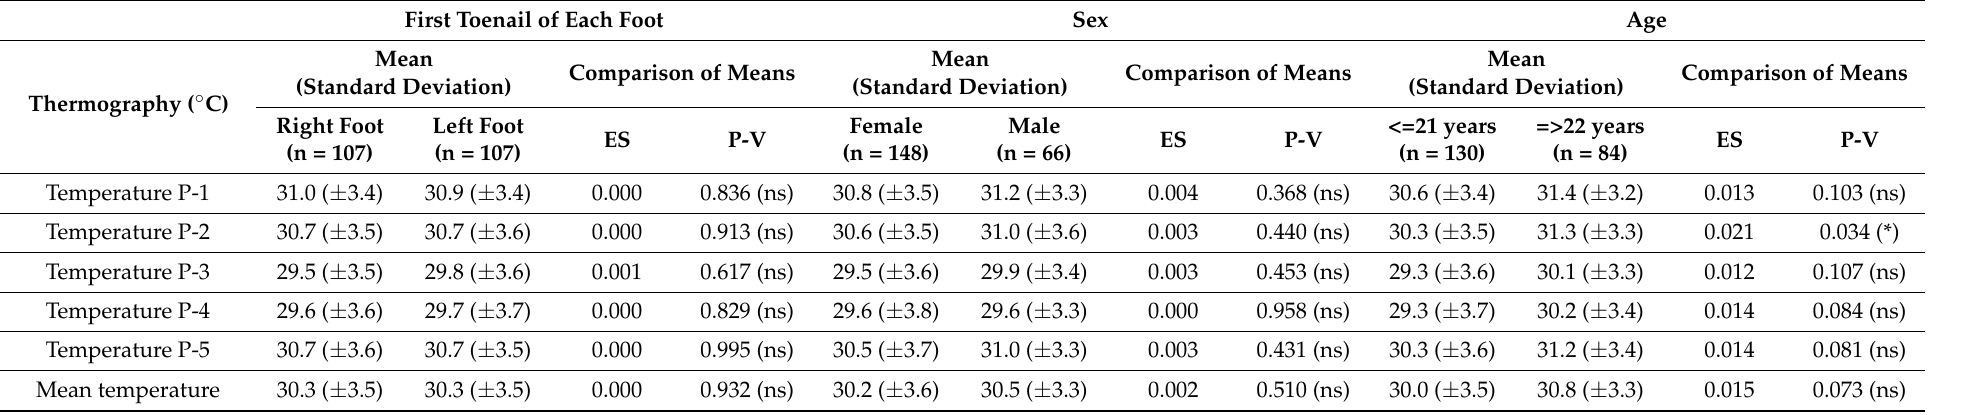
Table 3. Comparison of thermography variables by first toenail on each foot, sex and